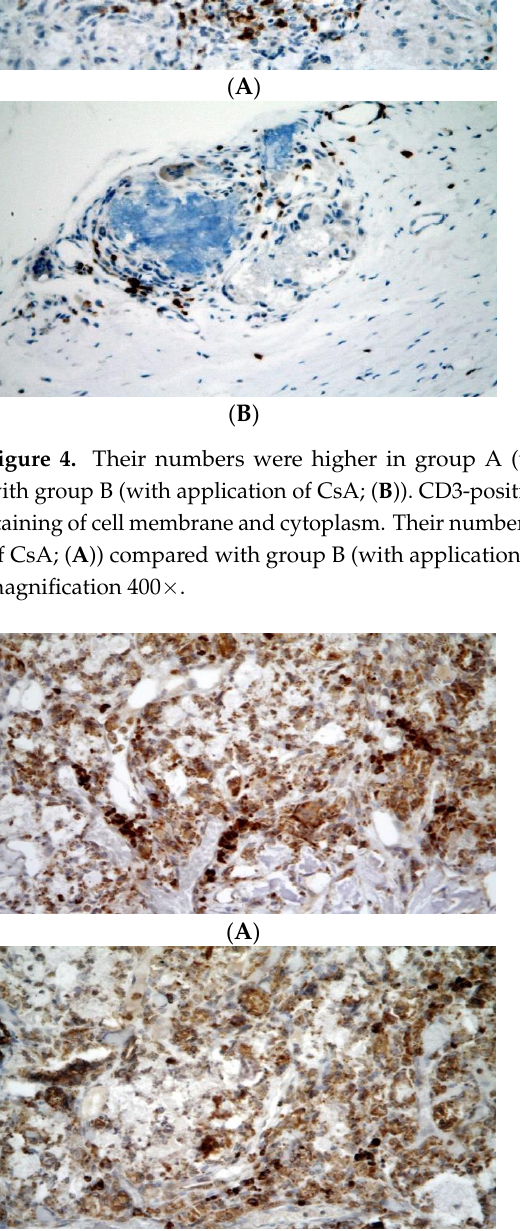
Figure 5. TRAP-positive cells were present in both group A (without application of CsA; ( A )) and group B (with application of CsA; ( B )) in roughly similar amounts. Their exact counting was not possible due to higher non-specific background. Immunohistochemistry, original magnification 400 ×